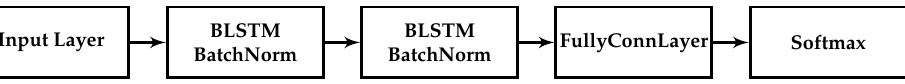
Figure 4. Architecture of the filter